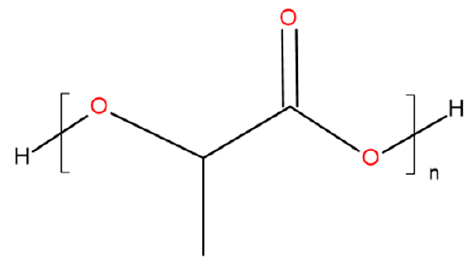
Figure 2. Chemical structure of PLA.